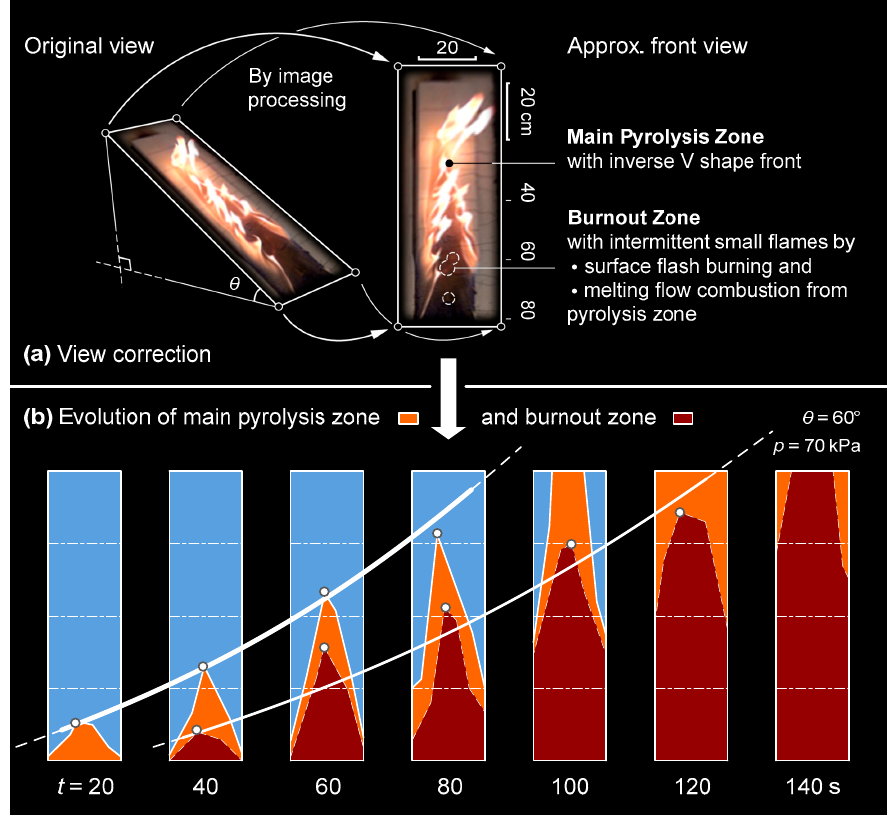
Figure 2. Evolution of pyrolysis and burnout zone profiles (typical results under 70 kPa and inclination 60° condition) during upward flame spread ( b ) by digital image view correction ( a ).